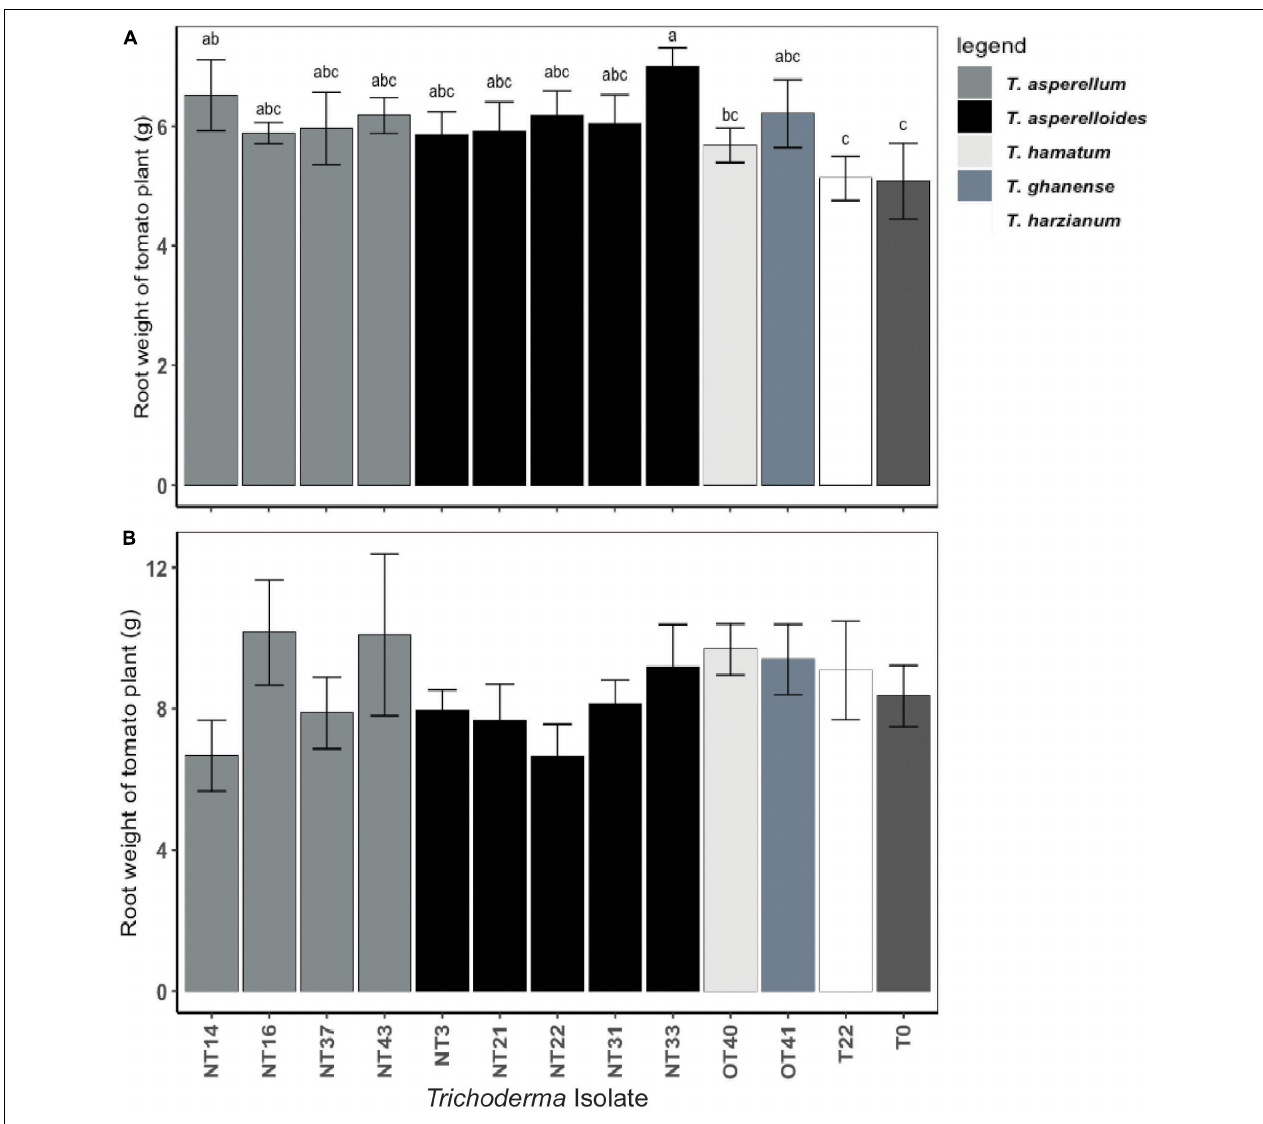
FIGURE 4 | Effect of Trichoderma isolates on root weight of Roma tomato subjected to: (A) water deficit stress, (B) continuous irrigated conditions. Plants were harvested simultaneously with their counterparts subjected to a water deficit stress regimen 32 days after transplanting. The root fresh weights per plant were recorded. Values are means ± SE of three trials each with four replicates. Isolates with different superscripts are significantly different according to Fisher LSD test ( P < 0.05). Bar colors represent the species of tested